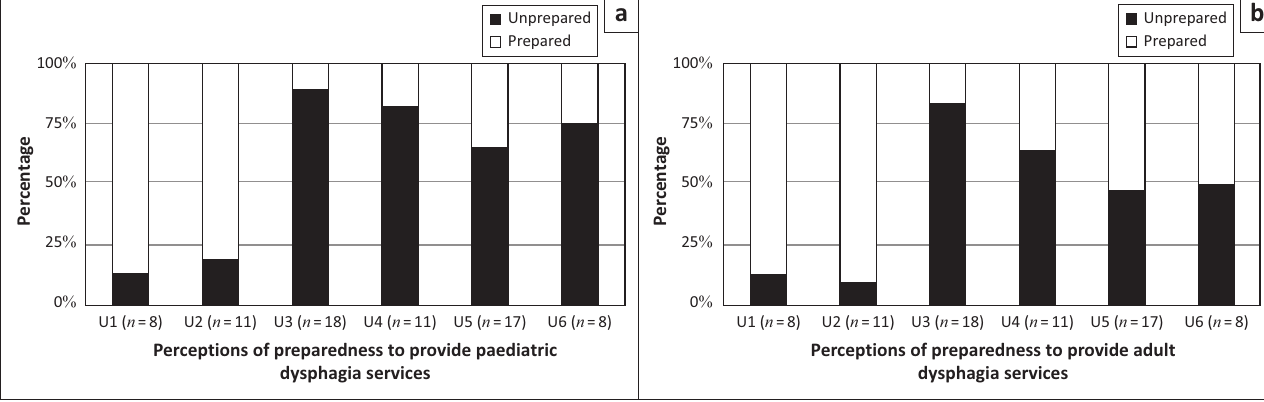
FIGURE 2: Perceptions of preparedness to provide paediatric and adult dysphagia services across universities ( N =